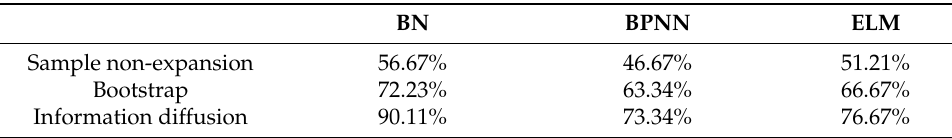
Table 12. Assessment accuracy of different models.